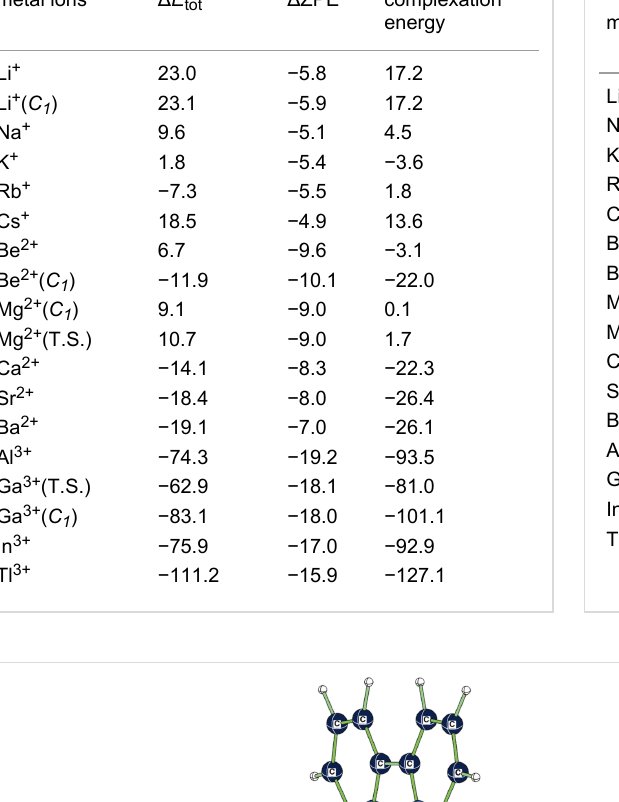
Table 4: Energy contributions (kcal/mol) to the complexation energy for [M 2.bpy.bpy] m+